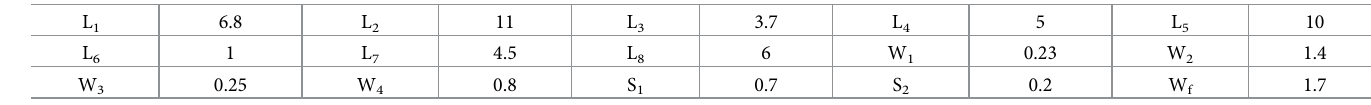
Table 1. Proposed triband filter geometrical parameters in millimeter